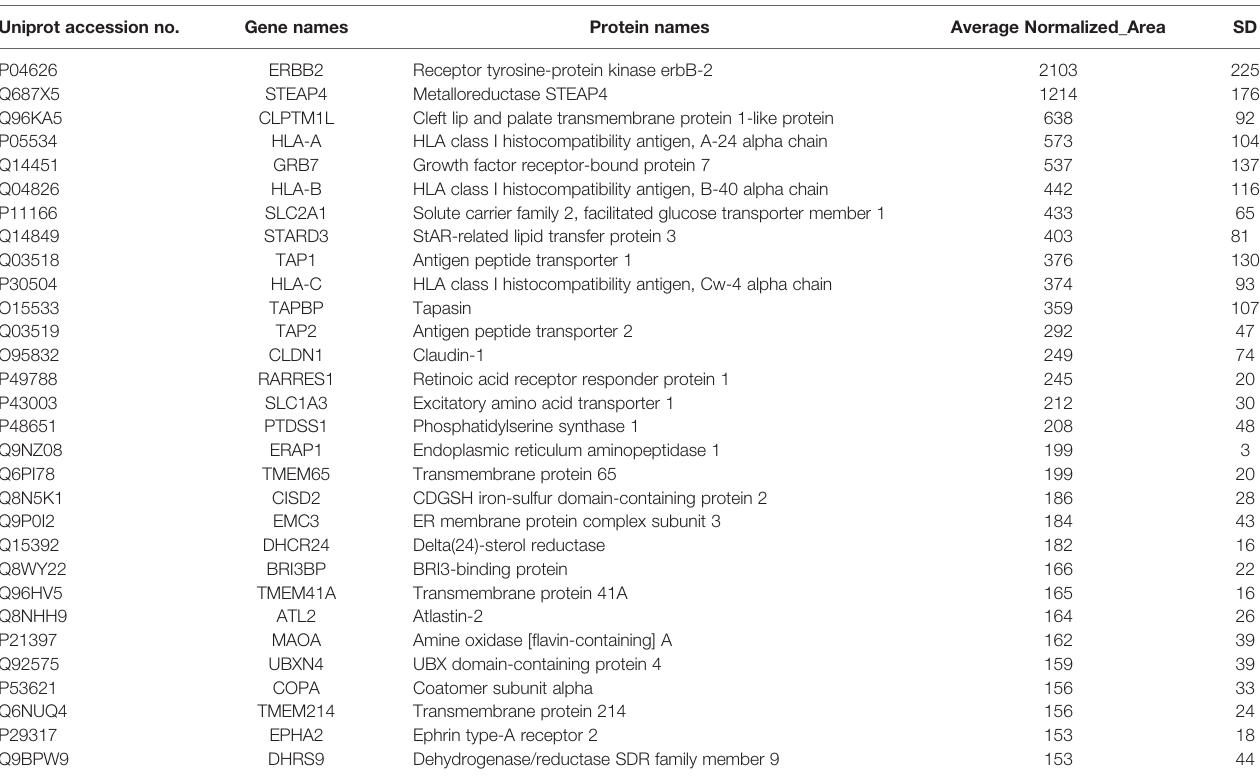
TABLE 1 | Selected membrane associated proteins speci fi cally identi fi ed in HCC-1954 compared to MCF-10A cells. Uniprot accession